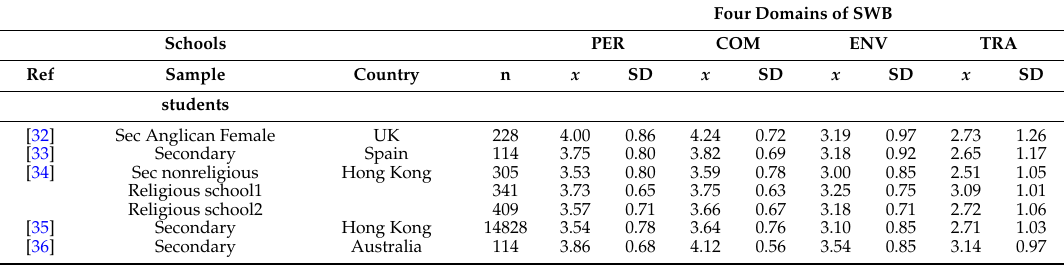
Table 1. Spiritual well-being (SWB) levels from recent studies using the Spiritual Well-Being Questionnaire–Spiritual Health and Life-Orientation Measure